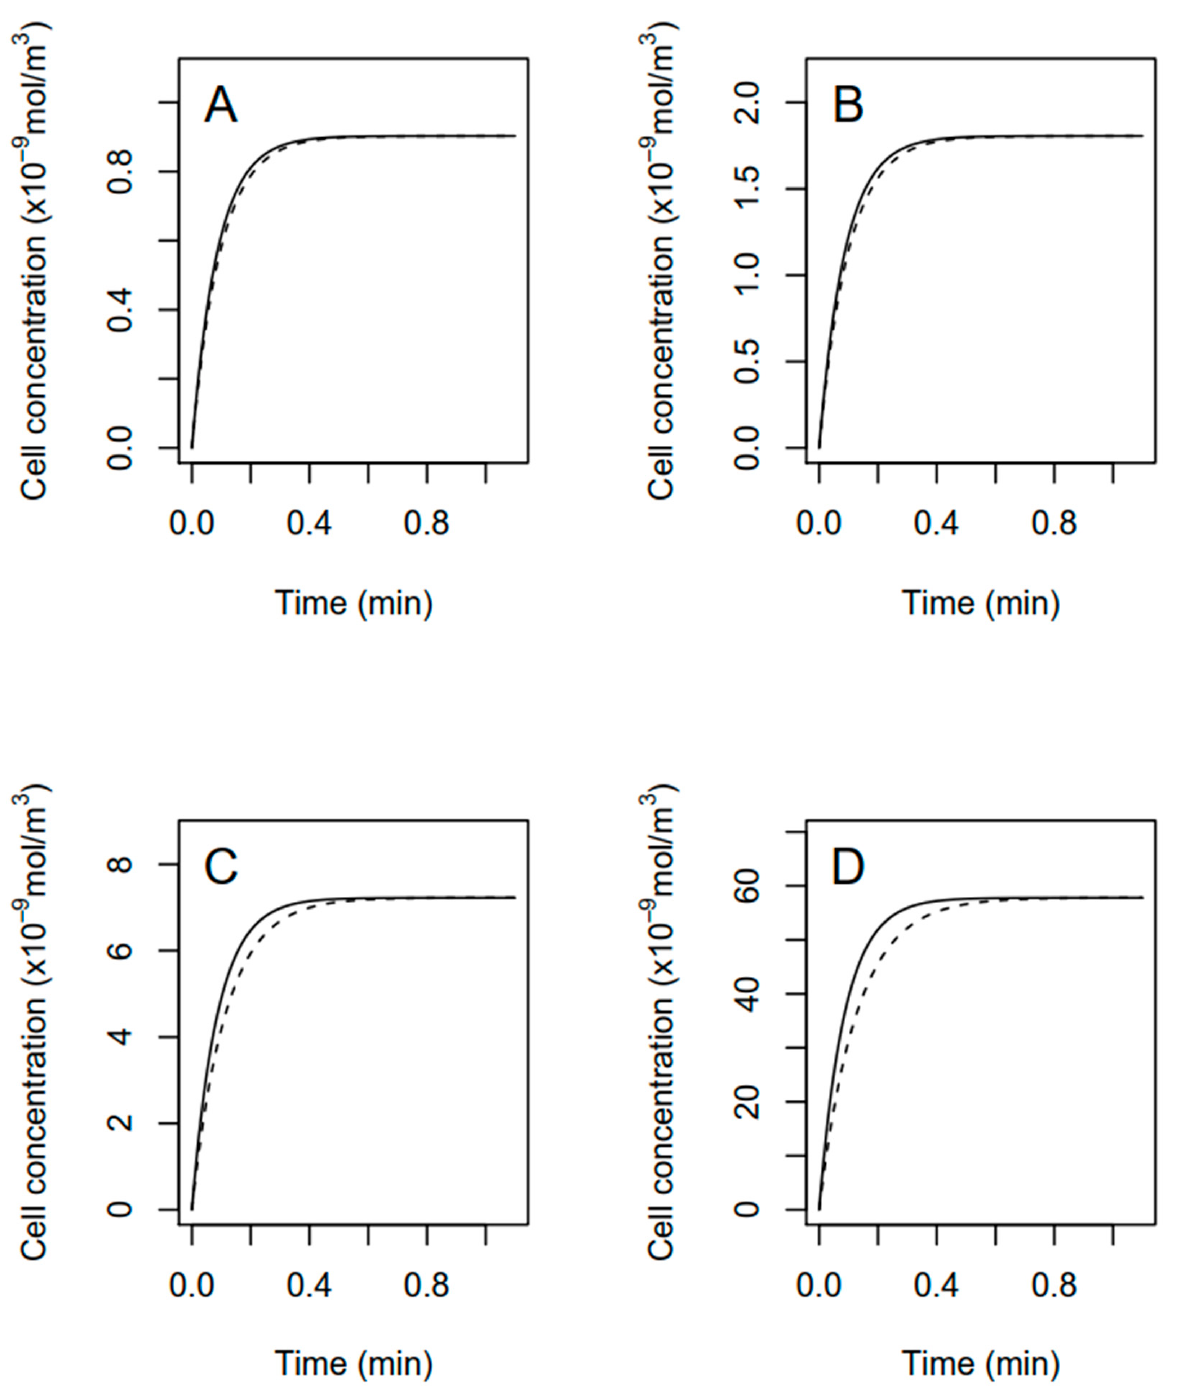
Figure 9. Modeled cellular concentration of fomesafen in R. subcapitata exposed to 5, 10, 40 and 320 μ g · L − 1 (panel A – D ) total fomesafen until approaching steady-state. Computations assume that fomesafen can be actively excreted or metabolized from the cell with an assumed high-rate constant for fomesafen loss on the order of the modeled uptake rate constant. Solid lines assumed a low constant cell biovolume equals to the mean measured initial cell biovolume. Dashed lines assume a high constant mean cell biovolume measured after 72 h of